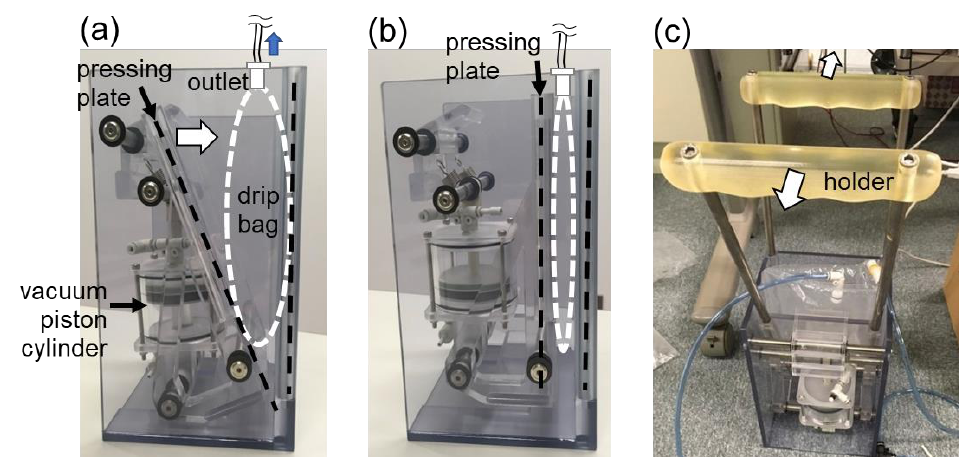
Figure 2. Prototype V-PRESS. ( a ) A piston is at the starting position of cylinder. A pressing plate is at the standby position before moving towards the drip bag. ( b ) The piston is at the end position of cylinder. The pressing plate fully compresses the drip bag. ( c ) The pressing plate is reset to the starting position by pulling the two holders away from each other.